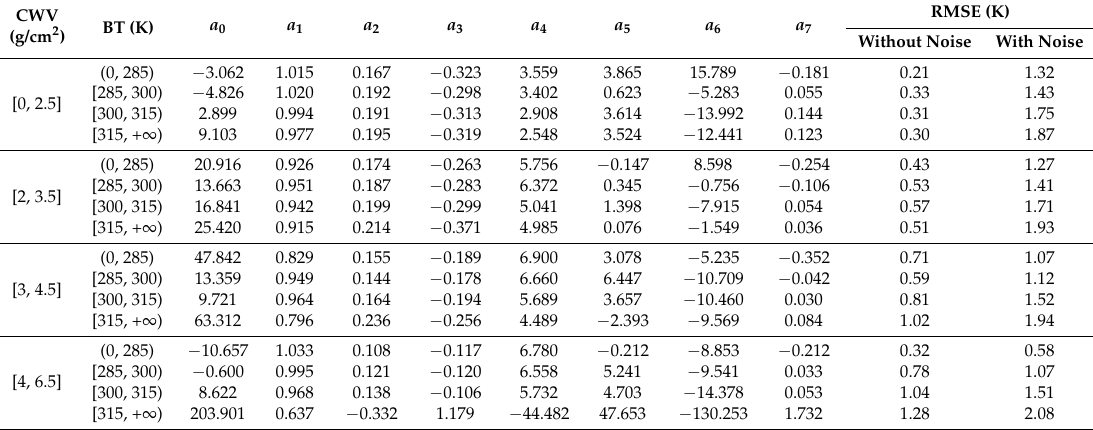
Table 1. Coefficients and root-mean-square errors (RMSEs) of different subranges for the daytime algorithm where view zenith angle (VZA) = 0°.